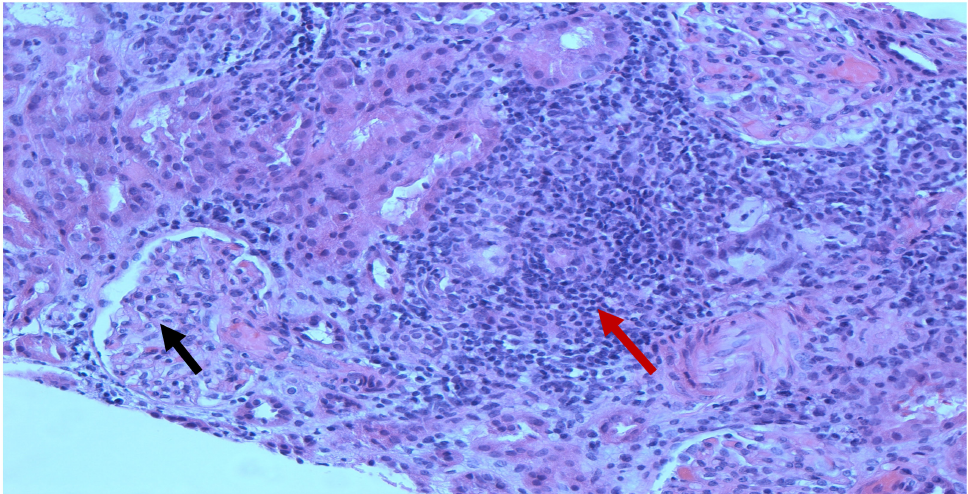
Figure 1. Renal biopsy. Light microscopy (H&E) showing mild increase in mesangial cellularity with moderate increase in the mesangial matrix (black arrow) along with moderate to severe interstitial inflammation, comprising lymphocytes/mononuclear cells, plasma cells, some eosinophils, and rare neutrophils (red arrow).